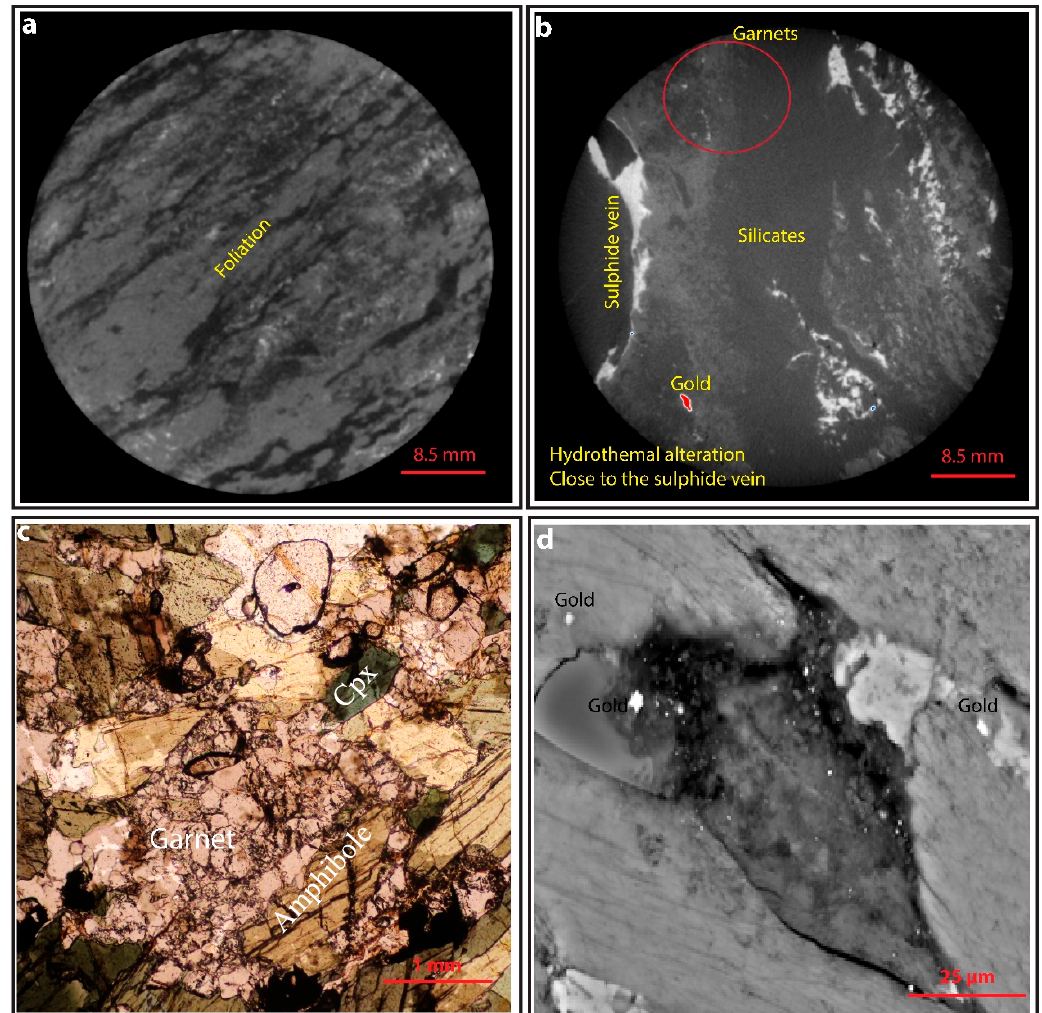
Figure 3. ( a ) Foliation within the silicates in the XCT image slice; the foliation is attributed to minerals biotite, amphibole, garnet, muscovite, quartz and feldspar. ( b ) XCT image slice of silicate matrix minerals bright pixels in red circle depicts garnet porphyroblasts identified as small round white dots. ( c ) Thin section made from the core proving the presence of garnet. ( d ) Backscattered gold elemental map obtained from the SEM analysis of the 2D cut surface of the core. The bright spots represent the spots where gold was found. Gold grains are small in SEM due to partial volume effect. Sample JJ01 and